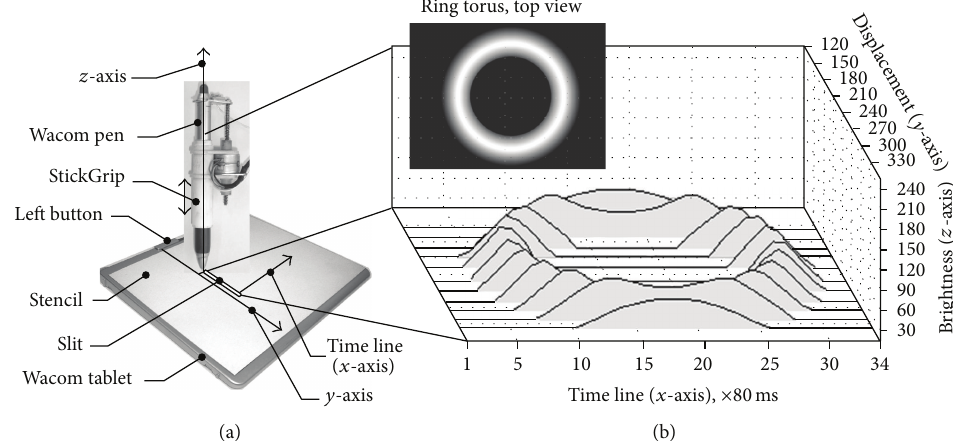
Figure 1: Dimensions of the haptic space (on the left) and visualization of exploratory patterns presented as the virtual cross-sectional slices of the upper half of the ring torus (on the right).